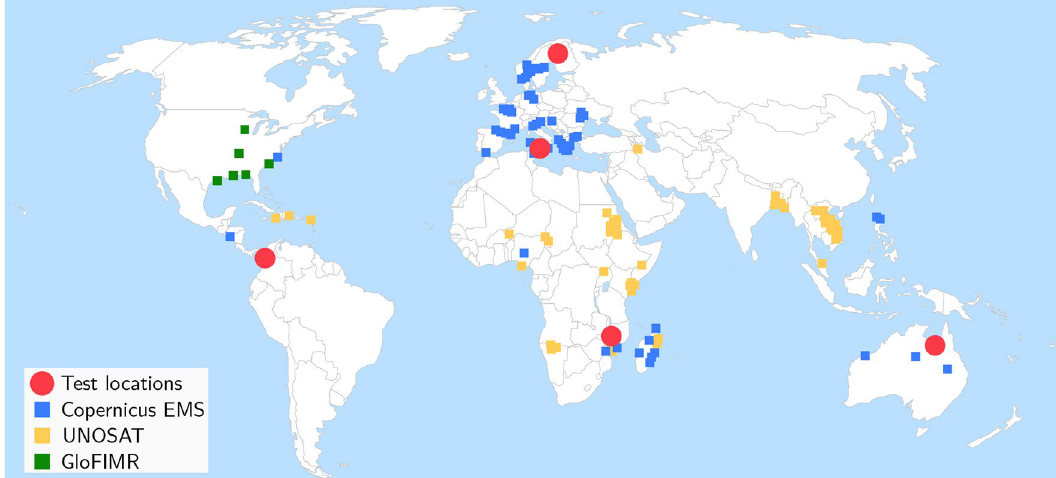
Figure 3. Locations of flood events contained in WorldFloods . Blue, orange and green areas denote Copernicus EMS, UNOSAT and GloFIMR data, respectively. Red circles denote test regions. Basemap credit: http:// www. simpl emaps.